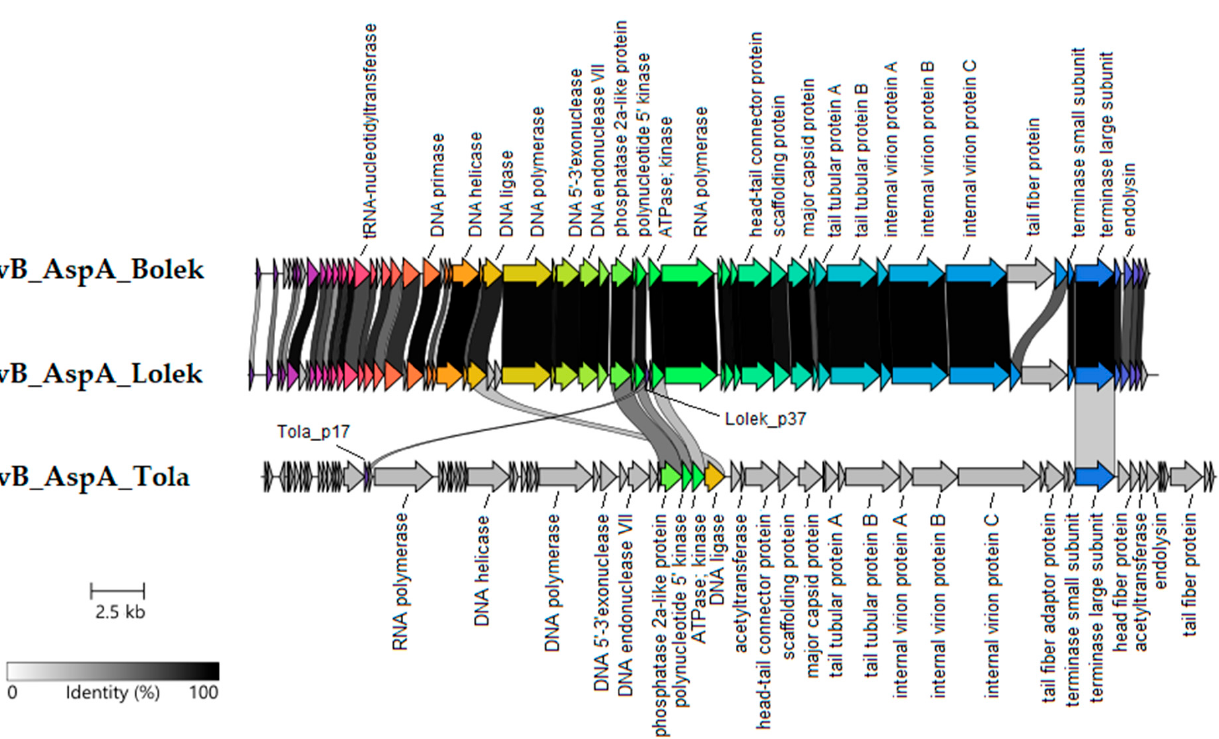
Figure 4. Comparative genome alignment of the Bolek, Lolek, and Tola phages. Coding sequences are represented by arrows, colored to reflect homologous ones, and are linked by grey bars shaded to represent the percentage of amino acid identity, as indicated in the legend.